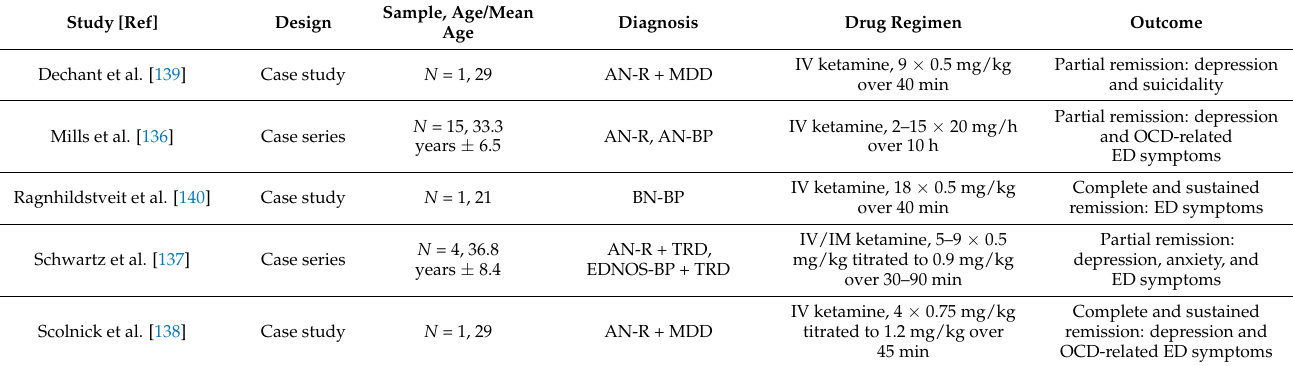
Table 1. Characteristics and outcomes of studies using ketamine to treat eating